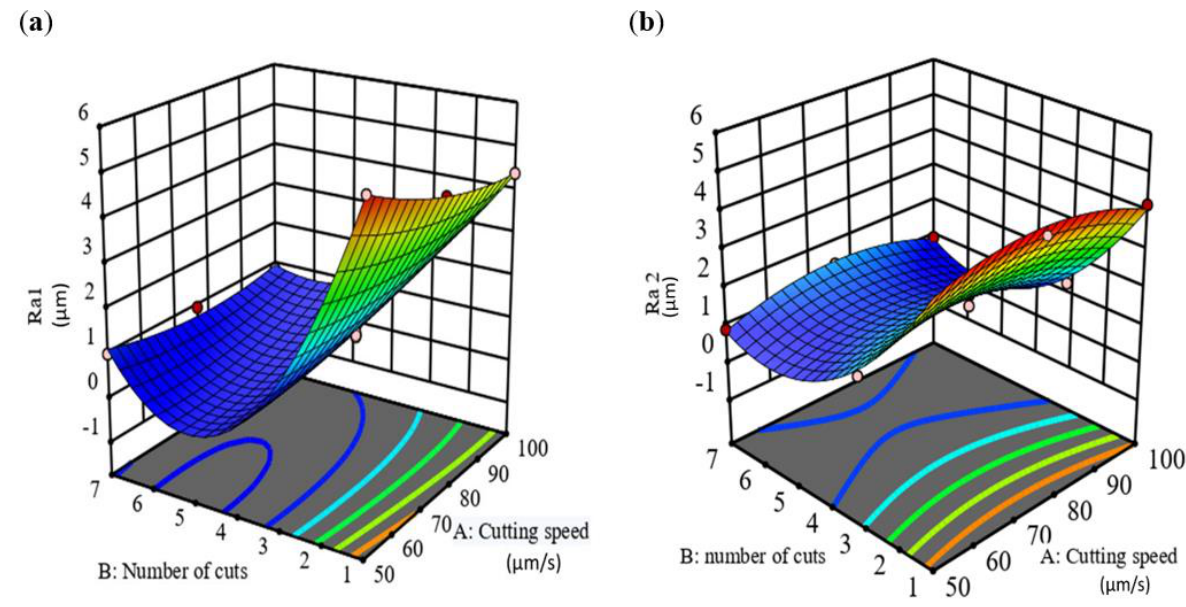
Figure 13. Effect of cutting process variables on surface roughness 3D for ( a ) Ti-6Al-4V (Ra 1 ) and ( b ) Ti-6Al-7V (Ra 2 ) alloys.